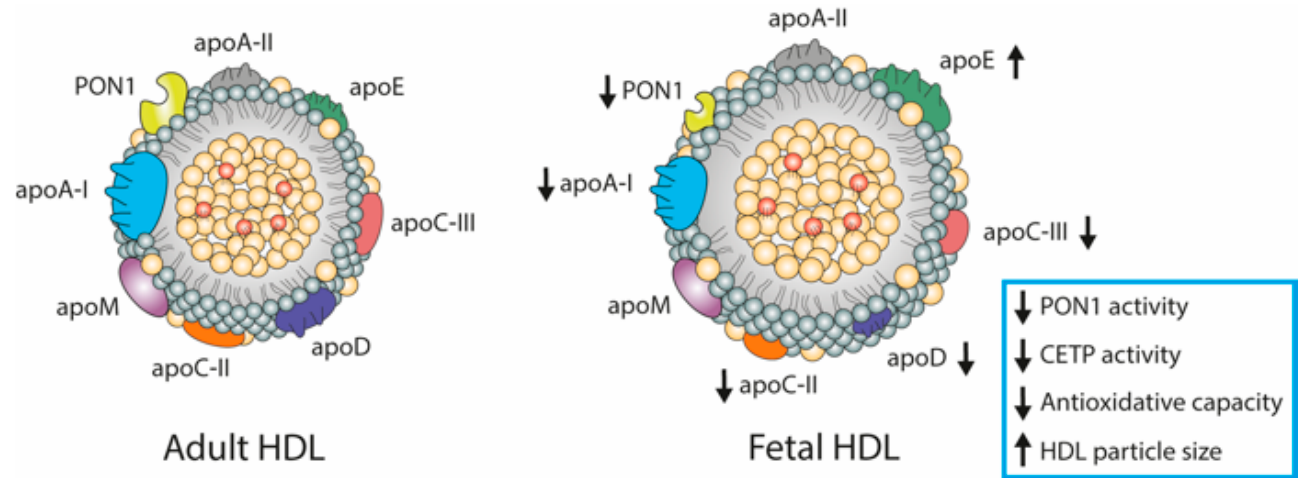
Figure 2. Schematic representation of differences between adult ‐ and fetal HDL composition and function (indicated with black arrows). Cord blood ‐ derived HDL exhibits several alterations in the apolipoprotein composition, such as decreased levels of apoA ‐ I, apoC ‐ III, apoD, and apoC ‐ II and higher levels of apoE. In the fetus, the activity of CETP is decreased, while the mass and activity of PON1 and the antioxidative capacity are decreased. Fetal HDL is characterized by increased HDL particle size. HDL, high ‐ density lipoprotein; apo, apolipoprotein; PON1, paraoxonase 1; CETP, cholesteryl ‐ ester transfer protein.